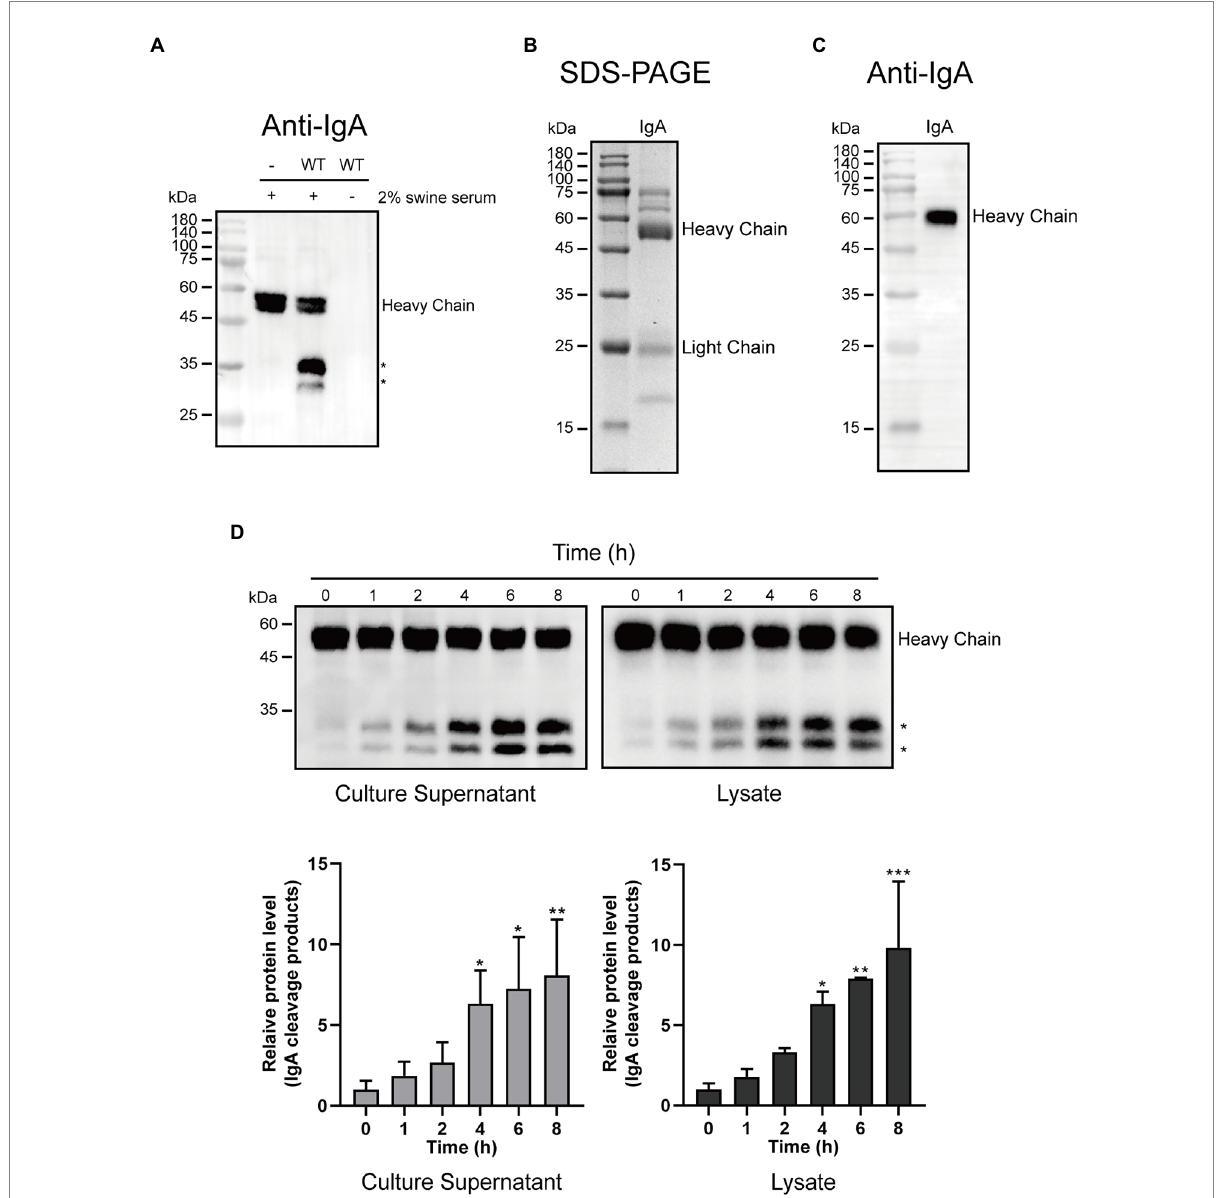
FIGURE 1 Glaesserella parasuis exhibits the ability to cleave swine IgA. (A) Culture supernatants of 2% heat-inactivated swine serum alone ( − ) and G. parasuis strain CF7066 cultured in the presence of 2% heat-inactivated swine serum to stationary phase were analysed by Western blot. IgA was detected with HRP conjugated Goat anti-Pig IgA antibody. The cleavage products are indicated with asterisk (*). SDS-PAGE (B) and Western blot (C) were used to assess the purification of swine IgA. (D) Culture supernatants and lysates were incubated with purified IgA at 37 ° C for different periods of time and analysed by Western blot.* p < 0.05, ** p < 0.01, *** p < 0.001 using one-way